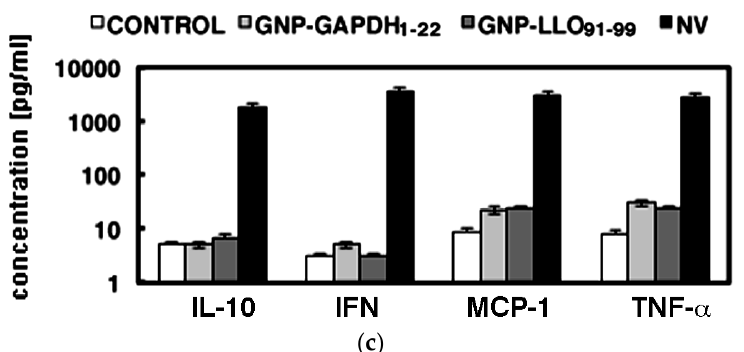
Figure 2. ( a ) P4-brain image corresponds to mixed microglía (MG) cultures of cerebellum brains showing green fluorescence of green fluorescence protein Listeria monocytogenes (GFP-LM), red fluorescence of the macrophage marker F4/80 and blue fluoresecence of neuron tubuline. P4-MG corresponds to purified MG of mixed cultures showing green fluorescence of GFP-LM, red fluorescence of actin cytoskeleton stained with TRITC-phalloidin and blue fluorescence of tubuline; ( b ) colony-forming-units (CFU)/mL in MG of newborn P4 pups (NB) born to NV mothers, GNP-LLO 91–99 or GNP-GAPDH 1–22 vaccinated mothers. CFU/mL in livers and spleens of NV mothers are also examined; ( c ) Cytokines levels (pg/mL) in supernatants of MG of newborn P4 pups born to mothers as in Figure 1.